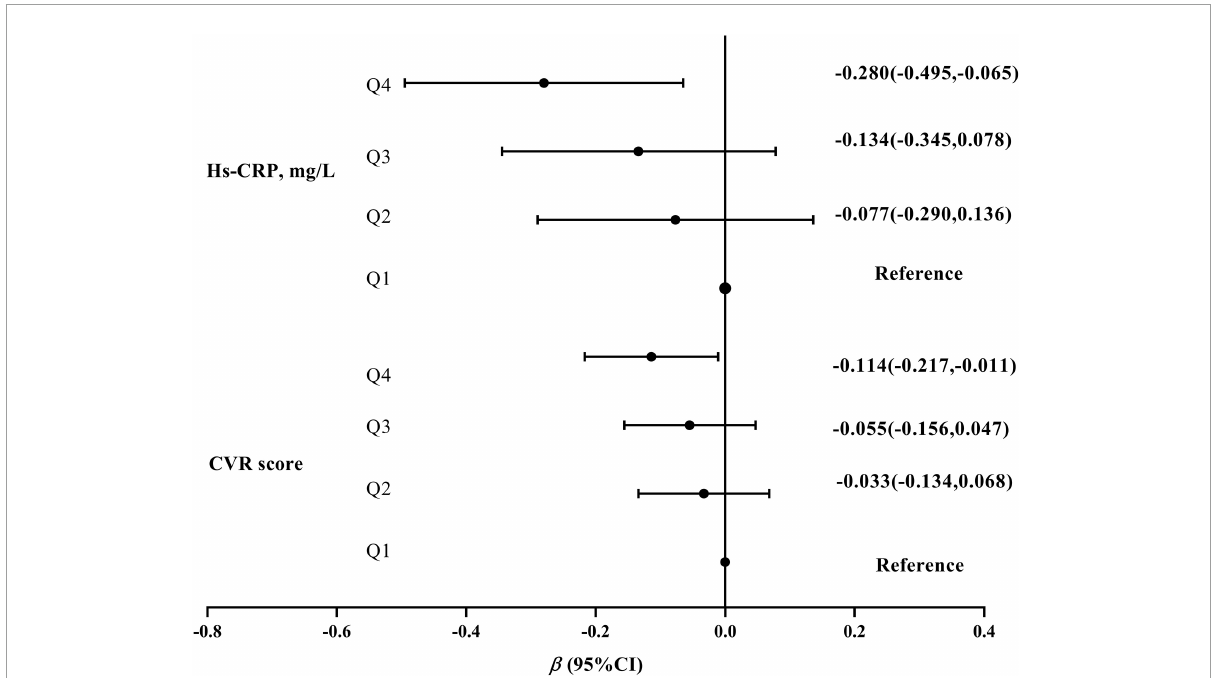
FIGURE2 The association of 25(OH)D concentrations with CVR scores and hs-CRP levels. 25(OH)D concentrations were divided into four groups by the quartile (Q1\Q2\Q3\Q4). All models were based on the multiple linear regression and adjusted for age, residence, education, income, pre-pregnancy BMI, parity, gestational weight gain, family history of diabetes and hypertension, physical activity, outdoor time, sedentary time, and vitamin D supplementation frequency. CVR, cardiovascular risk.